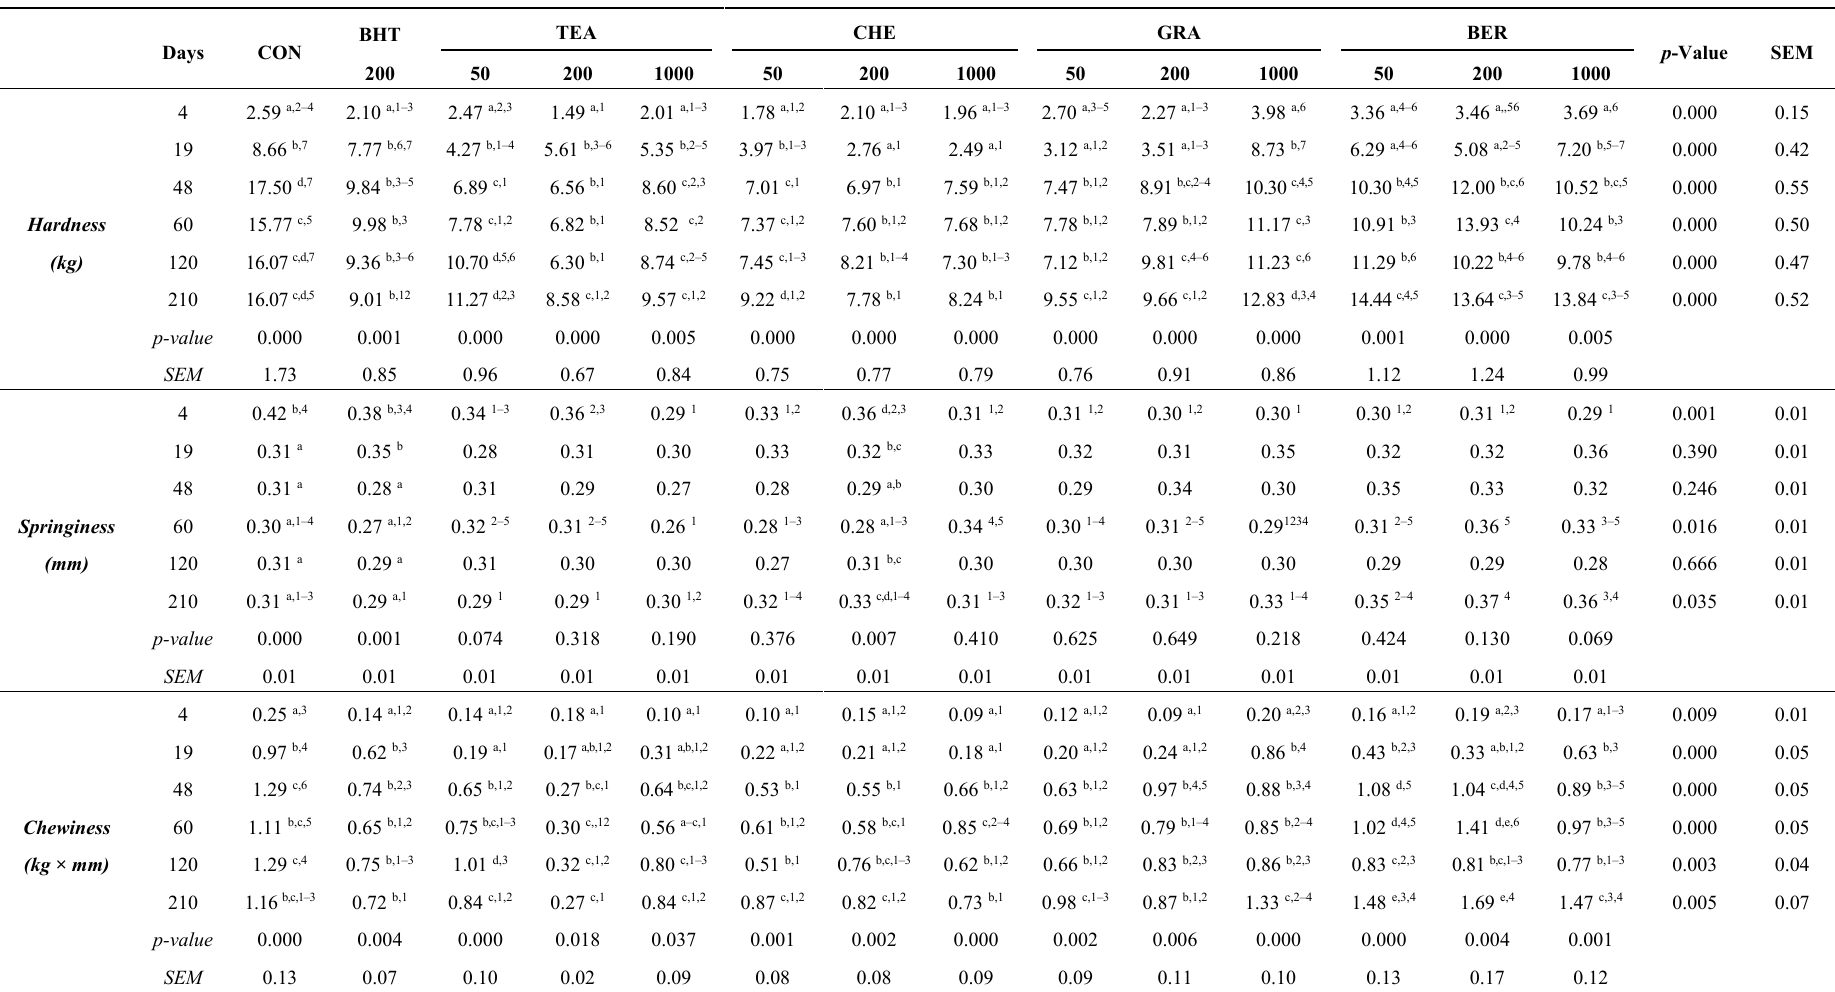
Table 2. Evolution of textural properties of “chorizo” treated with BHT and natural antioxidants during ripening and